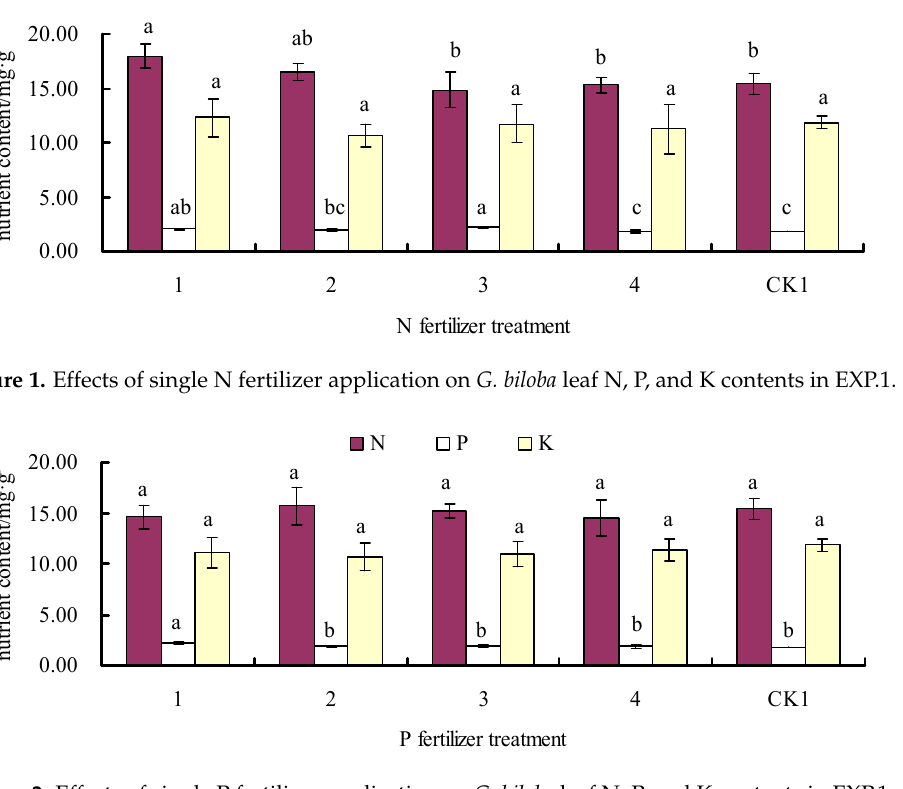
Figure 2. Effects of single P fertilizer application on G. biloba leaf N, P, and K contents in EXP.1.